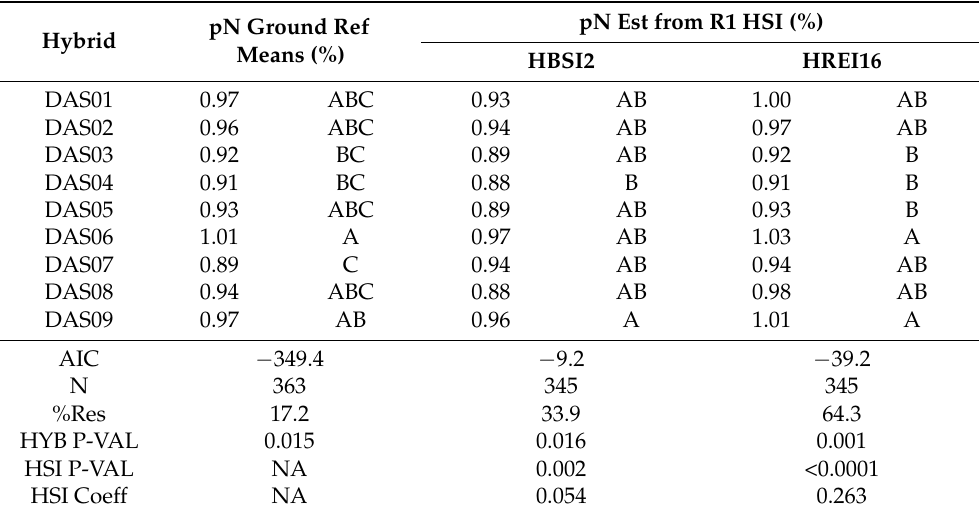
Table 7. Fit statistics and least square means estimates for ground reference and HSI models for pN (%). Hybrid means with different letters are significantly